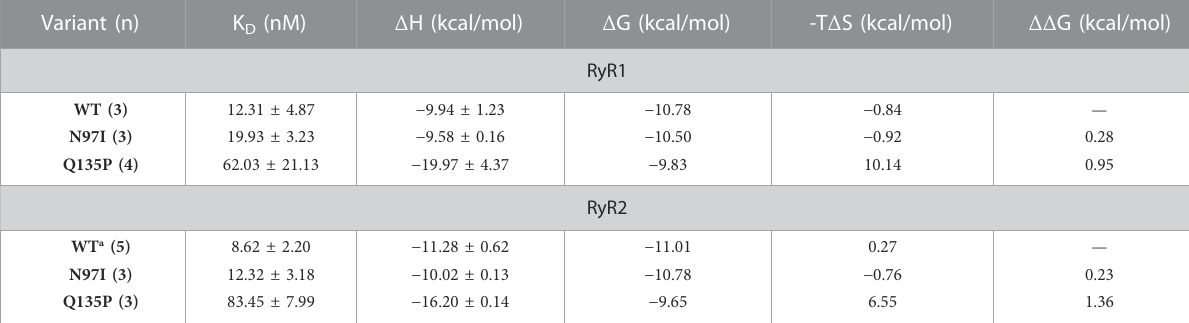
TABLE 2 Thermodynamics of CaM-RyR1/2 peptide association assessed by isothermal titration calorimetry.